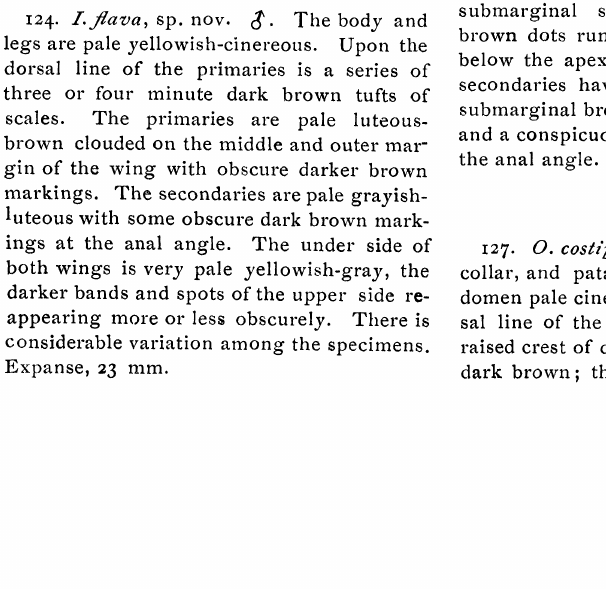
. Body wood- brown, primaries and secondaries of the same color, the outer margins of both wings clouded with darker brown. The primaries are marked on the cell by a number of min- ute blackish dots. The fringes of the prim- aries are dark brown, of the secondaries, pale cinereous. On the under side, both vings are paler, both have a conspicuous distal dot at the end of the cell. The primaries have a submarginal series of conspicuous dark brown dots running in a straight line from below the apex near the outer angle. The secondaries have two or three conspicuous submarginal brown dots near the outer angle and a conspicuous brown patch of scales at the anal angle. Expanse, 26